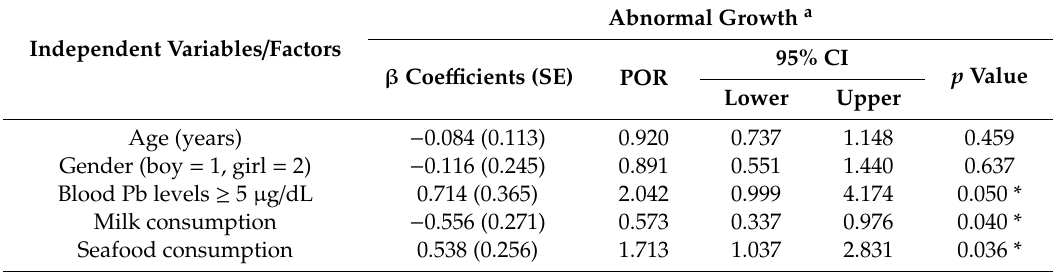
Table 3. Predictors of abnormal